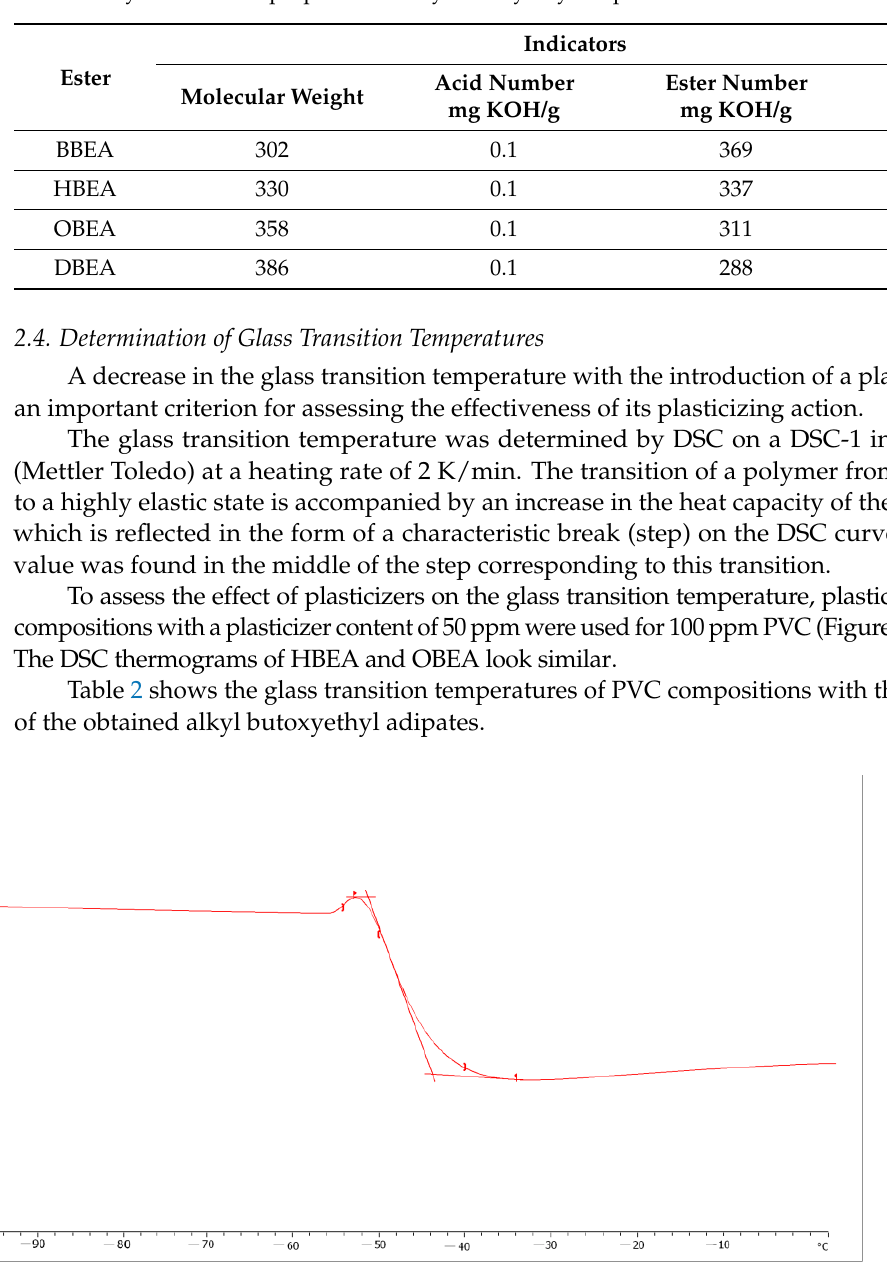
Ester in associates of aliphatic carboxylic acids. In the synthesized esters, the stretching vibra- tions of the carbonyl group are shifted to the high-frequency region and appear as a strong characteristic band corresponding to the ester bands in the 1737 cm − 1 region. There are also absorption bands that refer to the vibrations of the C-O-C ester fragment—1176 cm − 1 for butyl butoxyethyl adipate, 1175 cm − 1 for hexyl butoxyethyl adipate, 1173 cm − 1 for